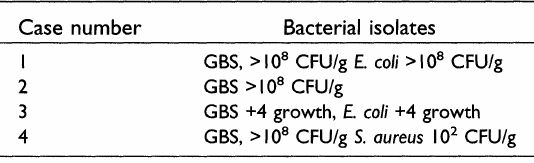
TABLE I. Microbiologic data derived from patients with GBS